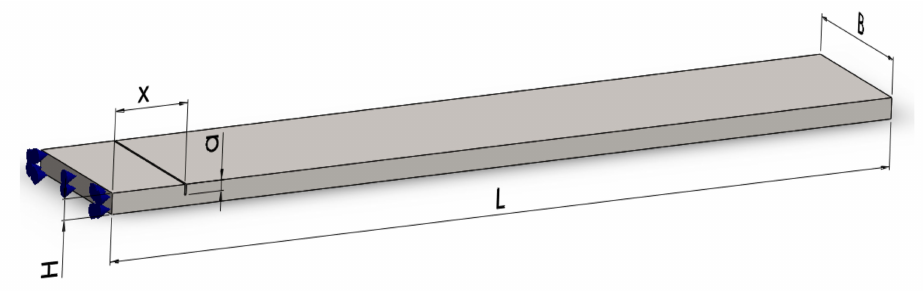
Figure 9. Main dimensions of the considered beam geometry with a transversal crack.